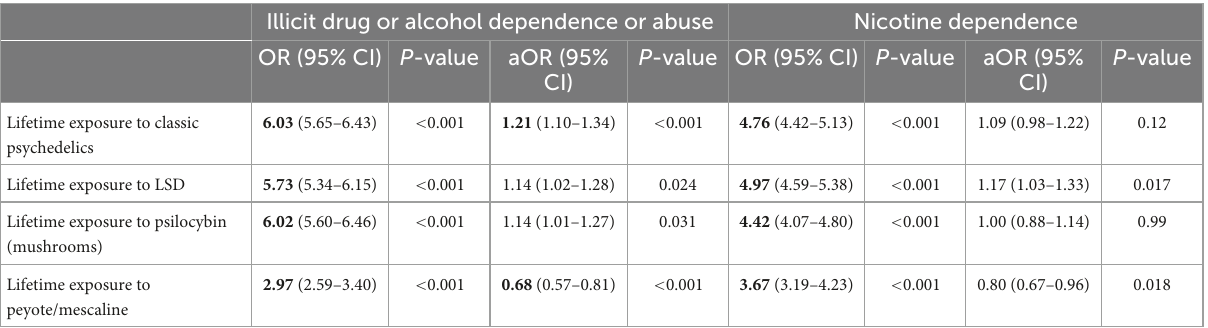
TABLE 3 Odds ratios (OR) and adjusted odds ratios (aOR) of past year illicit drug or alcohol dependence or abuse and nicotine dependence among individuals exposed to classic psychedelics in comparison to individuals in the sample who have never used these psychedelics. Illicit drug or alcohol dependence or abuse